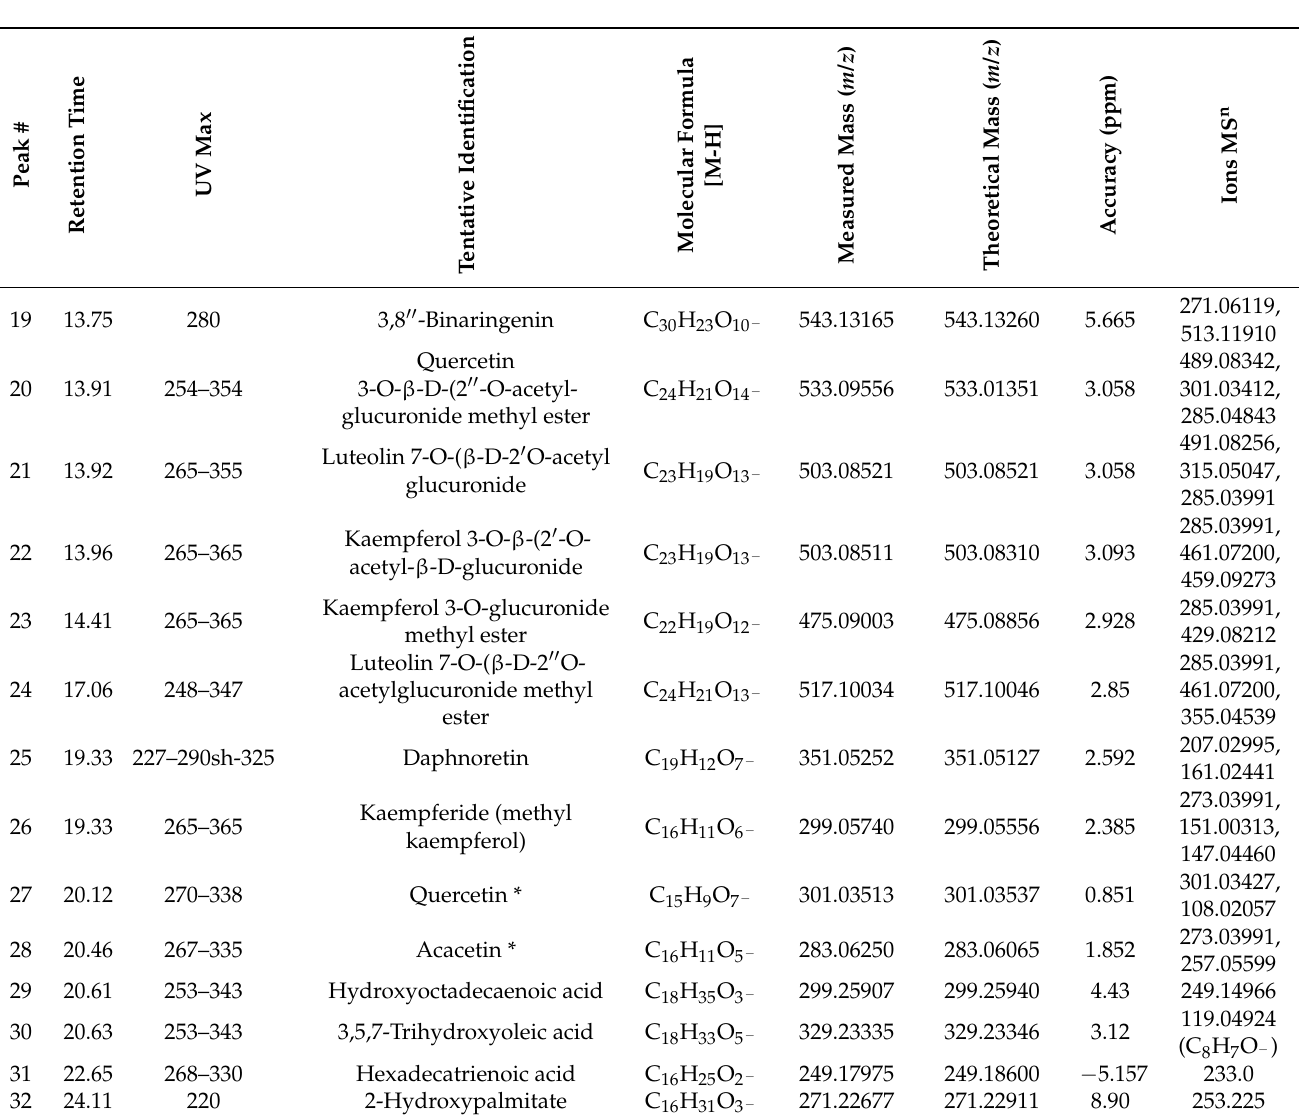
glucose (C 17 H 19 O 9 − ), and peak 7 as its isomer daphnetin 7 O-(5 ¨ -O-methyl-glucose 8-O- methyl ether. Peak 25 was identified as the dicoumarin daphnoretin (C 19 H 12 O 7 − ) [6]. 2.1.2. Phenolic Acids Peak 3 was identified as vanillic acid (C 8 H 8 O 4 − ), and peak 5 ion at m / z : 385.35066 as sinapoyl glucose (C 17 H 21 O 10 −